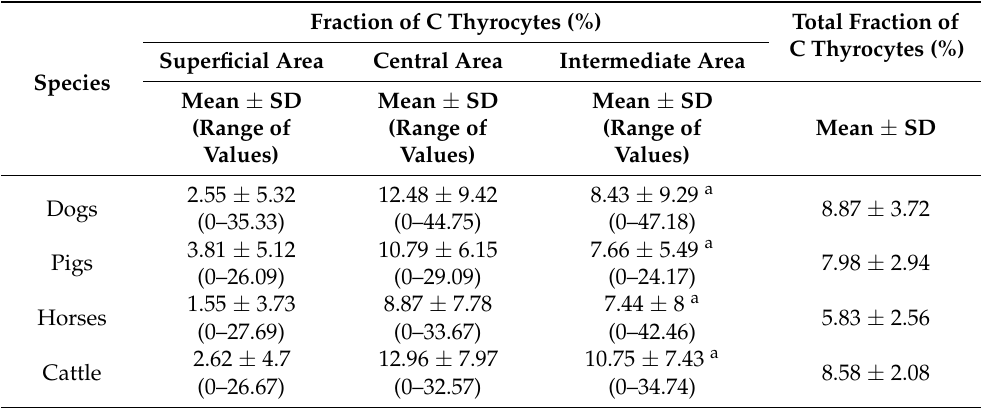
Table 1. Fraction of C thyrocytes in three different regions of the medial part of the thyroid lobe and total fraction of C thyrocytes in examined